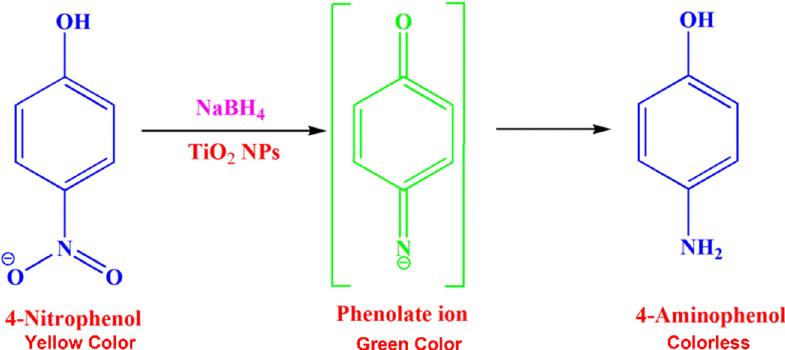
Figure 8. Mechanism of reduction of 4-nitrophenol to 4-aminophenol.